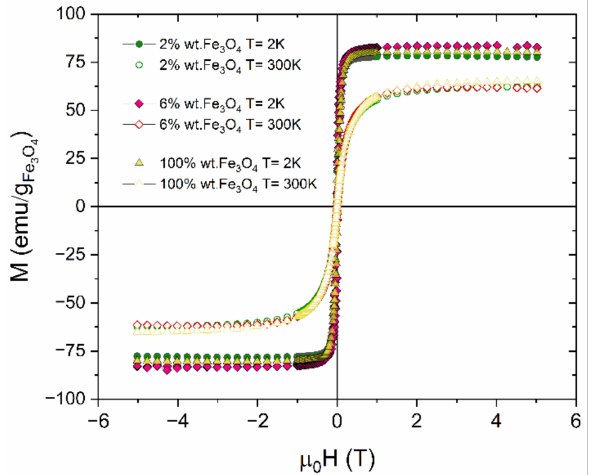
Figure 5. Hysteresis loops obtained for Fe 3 O 4 nanoparticles and PCL fibres with magnetite contents of 2 wt.% and 6 wt.% measured at 2 K and 300